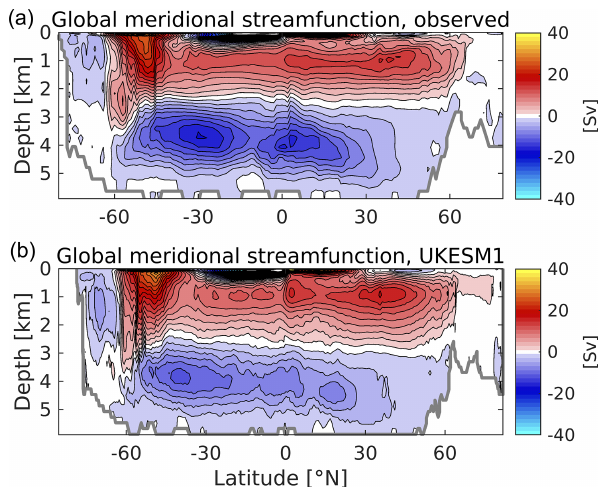
Figure 8. Observationally derived (a) and simulated (b) meridional overturning circulation (MOC) for the global ocean. The observa- tional circulation is derived from the ECCO V4r4 ocean circulation reanalysis for the period 1992–2017. The model circulation shown is based on the decadally averaged streamfunction, 2000–2009. Both plots include the components from parameterized mesoscale eddies (Gent and McWilliams, 1990; Gent et al., 1995). MOC is in Sv with a contour interval of